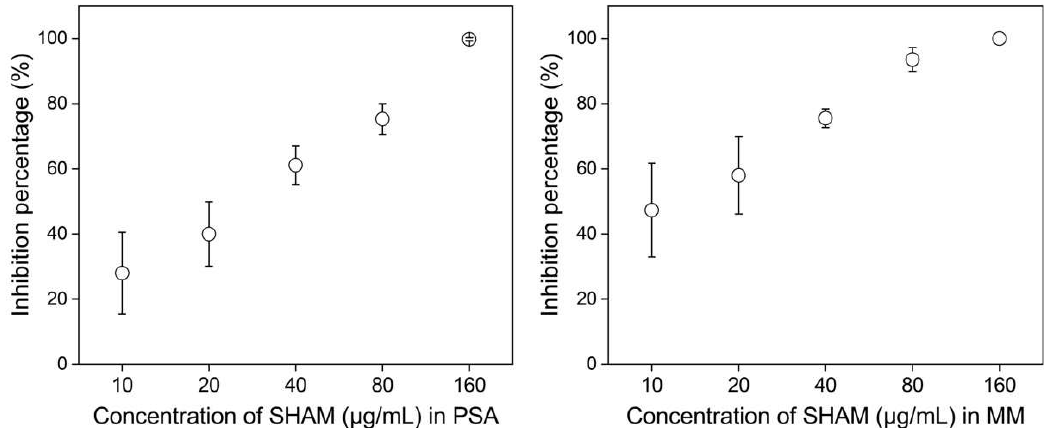
Figure 2. Dose response of mycelial growth of Ustilaginoidea virens to SHAM. Values are means of ten isolates; error bars represent standard errors of the mean. PSA, potato sucrose agar; MM, minimal medium.